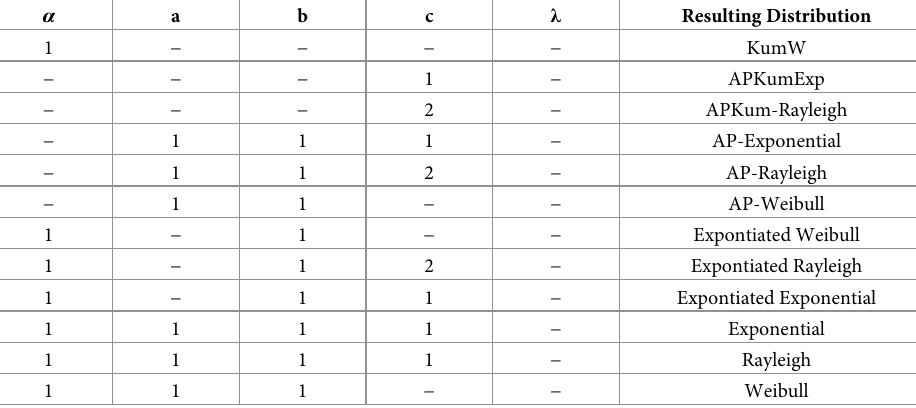
Table 1. Special models of the APKumW